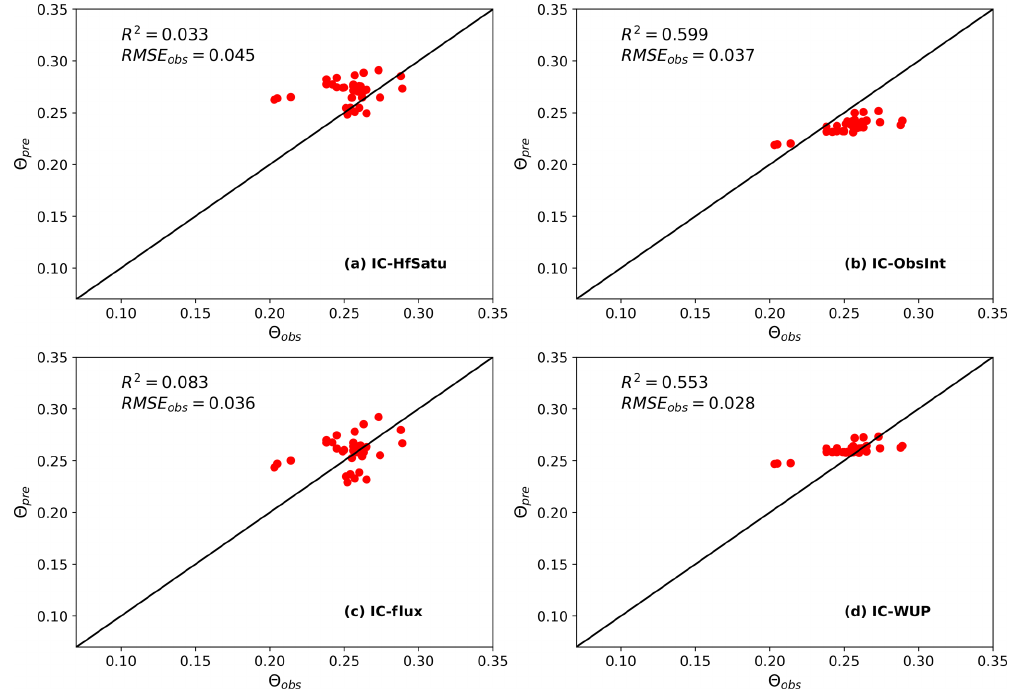
Figure 12. The comparisons between soil moisture observations and predictions (with estimated parameters from IES combined with differ- ent initialization methods) at all observation